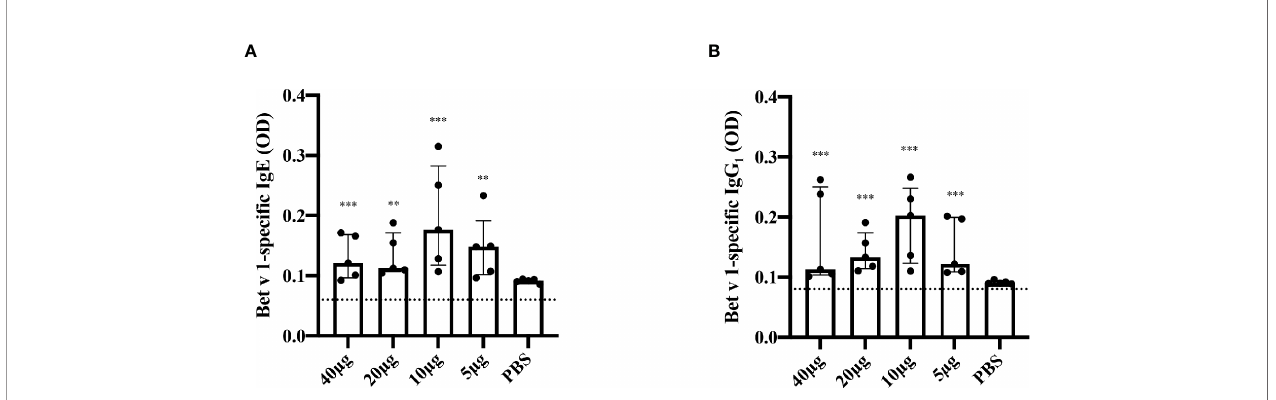
FIGURE 3 | Bet v 1-speci fi c IgE and IgG 1 -antibody responses after single subcutaneous sensitization with different Bet v 1 doses. Shown are serum levels (optical densities, ODs) of Bet v 1-speci fi c IgE (A) and Bet v 1-speci fi c IgG 1 (B) as scatter plots with medians and interquartile ranges ( y-axes ) for groups of mice (n = 5) four weeks after one subcutaneous injection of Al(OH) 3 adsorbed Bet v 1 (40µg, 20µg, 10µg or 5µg) or PBS ( x-axes ). Each data point represents the mean of a duplicate determination from an individual mouse. Data were analyzed by a general linear model with a log link, comparing Bet v 1 sensitized groups to PBS control group by linear contrast. Statistically signi fi cant differences between Bet v 1 sensitized groups to PBS control group are indicated (***P < 0.001, **P <